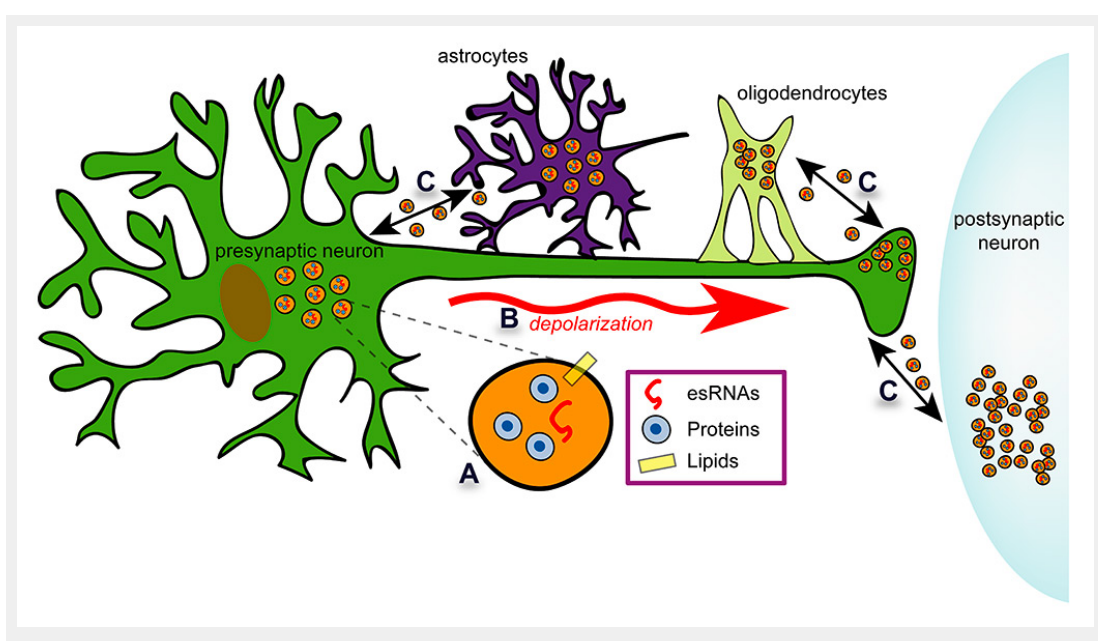
Figure 1 Regulation of exosomal function in the central nervous system. Black circles represent exosomes whose functions can be regulated in ( A ) intracellular cargo sorting; ( B ) space-time regulation of secretion; ( C ) cellular target specificity. esRNA = exosomal shuttle